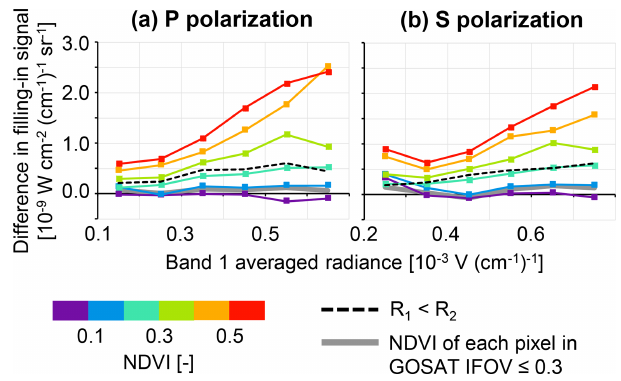
Figure 1. Temporal mean (May 2009 to January 2018) of the dif- ference in the monthly mean filling-in signal between data with R 2 < R 3 ( R i : albedo for the TANSO-FTS band i ) and data having different NDVI values, plotted against the averaged radiance of the TANSO-FTS band 1 for 30 to 45 ◦ N: (a) P polarization; (b) S polar- ization. Results derived from the data with R 1 < R 2 (dotted black line) and data with NDVI max ≤ 0 . 3 (solid black line) are also plot-